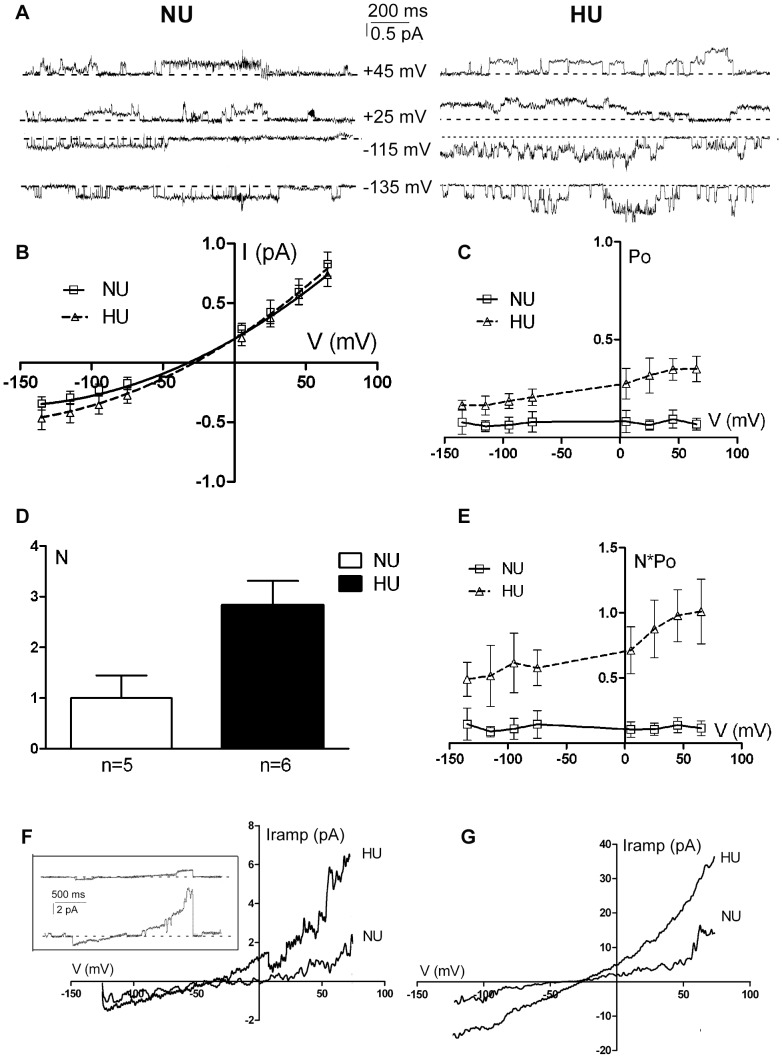
G460W adducin affects CFTR single channel activity.Chloride currents in NU12 and HU33 cells overexpressing the CFTR channel (patch-clamp, cell-attached configuration). A) Representative single-channel traces at positive or negative potentials as indicated, recorded in NU12 (NU, left panel) or HU33 cells (HU, right panel). The dotted line corresponds to the closed level. B) Single channel current-voltage (I–V) relation for CFTR in NU12 and HU33 cells (n = 5 and 6). C) Open probability (Po) versus potential plots for CFTR channels recorded in NU12 (n = 5) and HU33 cells (n = 6). D) Channel density in NU12 (n = 5) and HU33 (n = 6) cells (N = channel density, n = total number of seals). P<0.05. E) Channel activity, measured as N multiplied by channel open probability (Po), versus membrane potential for NU12 (n = 5) and HU33 (n = 6) cells. P<0.05. F) Mean current recorded during voltage protocol consisting of ramps from −135 mV to +65 mV, applied to cell-attached patches at a rate of 0.5 mV/ms. The I/V represents the mean current of 10 ramp protocols from 5 and 6 patch of NU12 and HU33 cells respectively. In the box representative single ramp records are reported for NU12 (upper ramp) and HU33 (lower ramp). G) Mean current recorded in the same condition as in F, after 3 minutes exposure to 10 µmol/L forskolin.